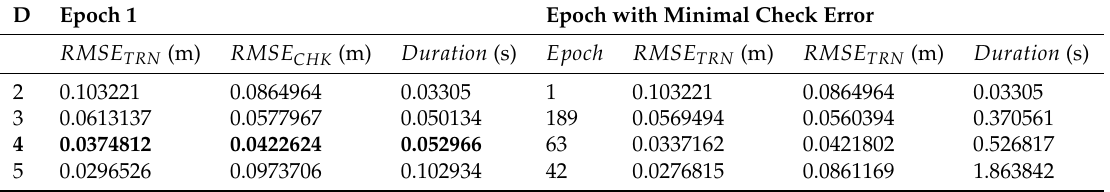
Table 4. The relationship between training points D, number of training epochs, RMSE , and duration of the training